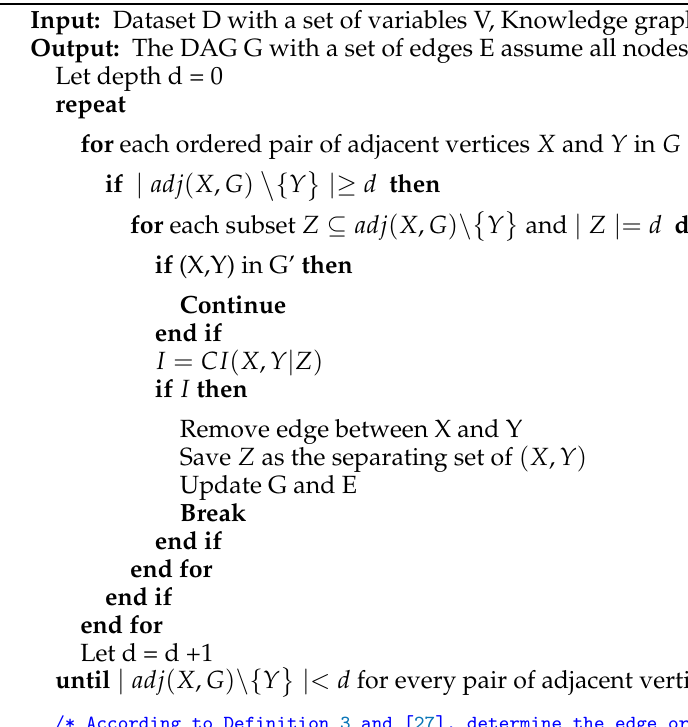
Algorithm 1: The optimized PC algorithm based on knowledge